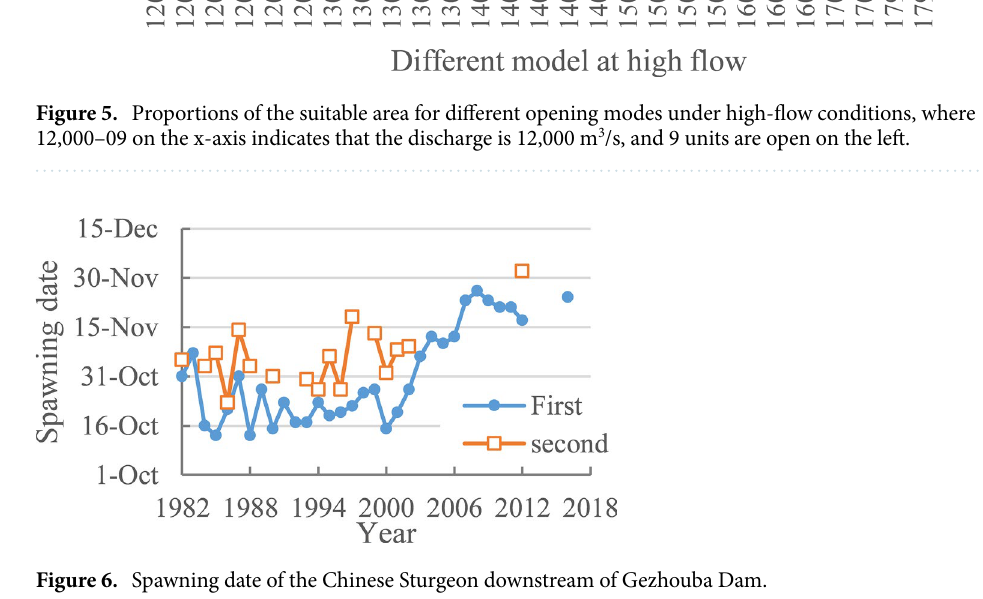
Figure 6. Spawning date of the Chinese Sturgeon downstream of Gezhouba